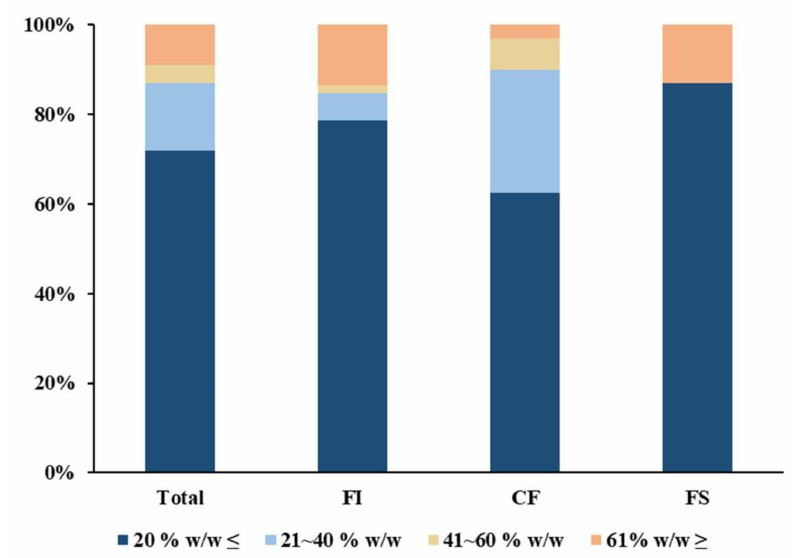
Figure 1. The moisture content of each feed to be investigated; 886 feeds in total: 476 feed ingredients (FIs), 379 compound feeds (CFs), and 31 feed supplements (FSs) ( n = 3). Therefore, in order to check the difference in recovery according to the moisture content of the feed during the extraction process, optimization was performed using blank pet feed samples with moisture contents of 0, 20, 40, 60, and 80% w / w at the middle validation levels (Table 1). As a result, the recovery where water was completely removed at 0% w / w was the highest, and most of the components showed a tendency toward decreased recovery as the feed water content increased (Figure 2). There was no significant difference in the recovery results between the feed containing 0 and 20% w / w water, but it